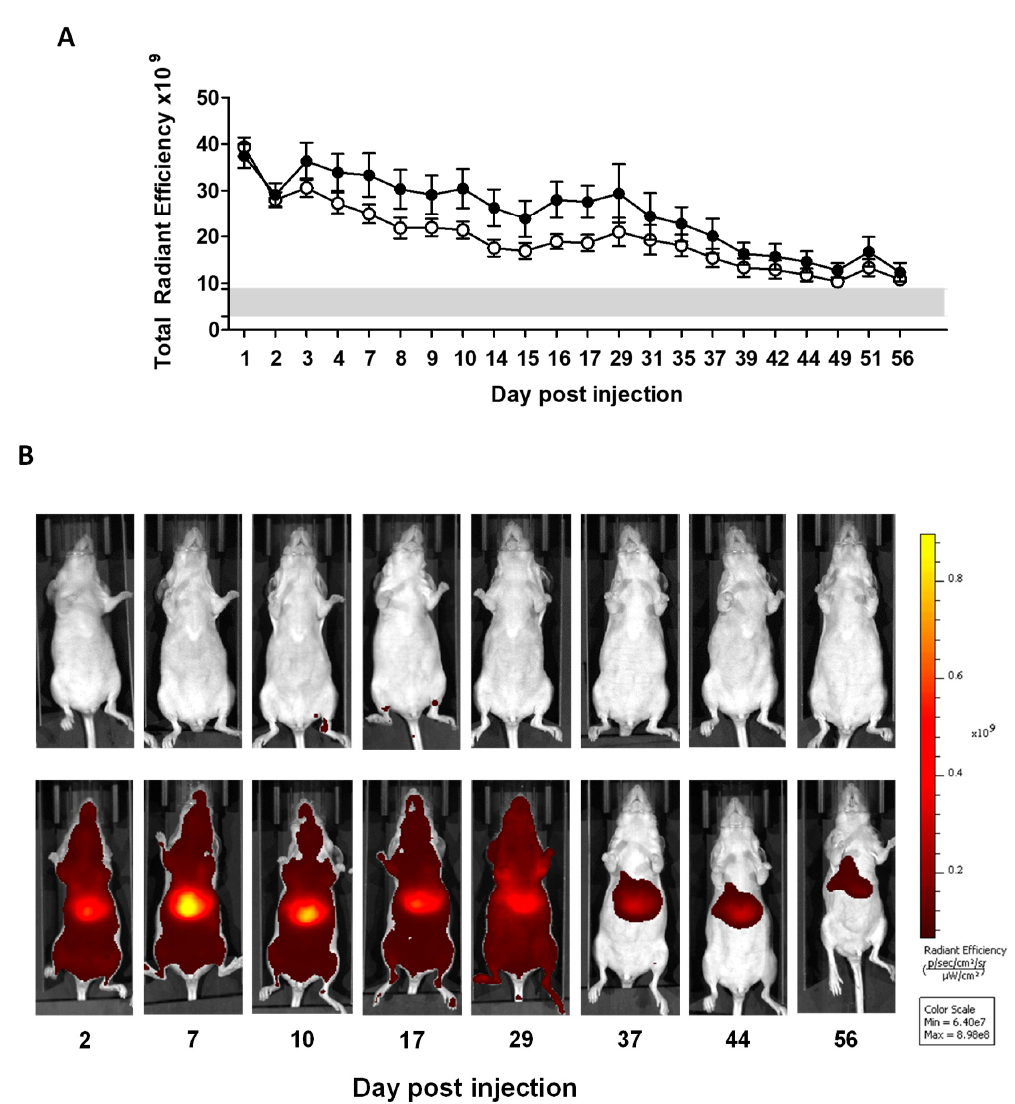
Figure 5. ( A ) Follow-up of the fluorescence in living mice after one IV injection of the ABP-NIR dendrimer. Whole body fluorescence was measured using the IVIS Spectrum imaging system. Black dots and white dots represent the values obtained on the ventral and on the dorsal sides, respectively (mean ± SEM, n = 6 mice). The grey bar represents the mean ± 2 SD of the fluorescence values measured for the dorsal side of the control group mice IV injected with PBS ( n = 2 mice). ( B ) Images from the ventral side of one mouse representative of each group. The intense fluorescent spot encompasses the abdominal